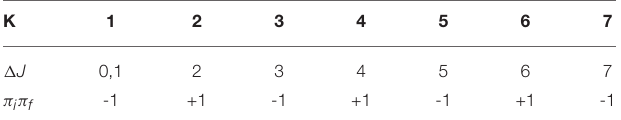
TABLE 4 | The change in angular momentum and parity in a Kth forbidden non-unique β